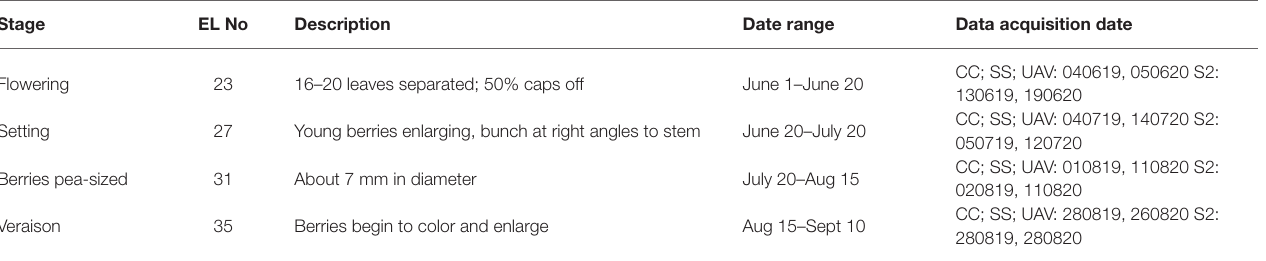
TABLE 1 | Grapevine seasonal EL growth stages of proximal and remote sensing data acquisition.